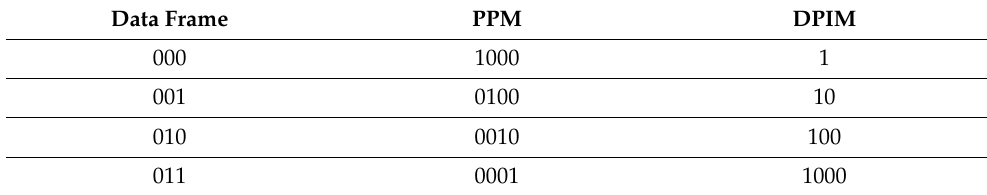
Table 2. Modulation Data Frame PPM, DPIM.